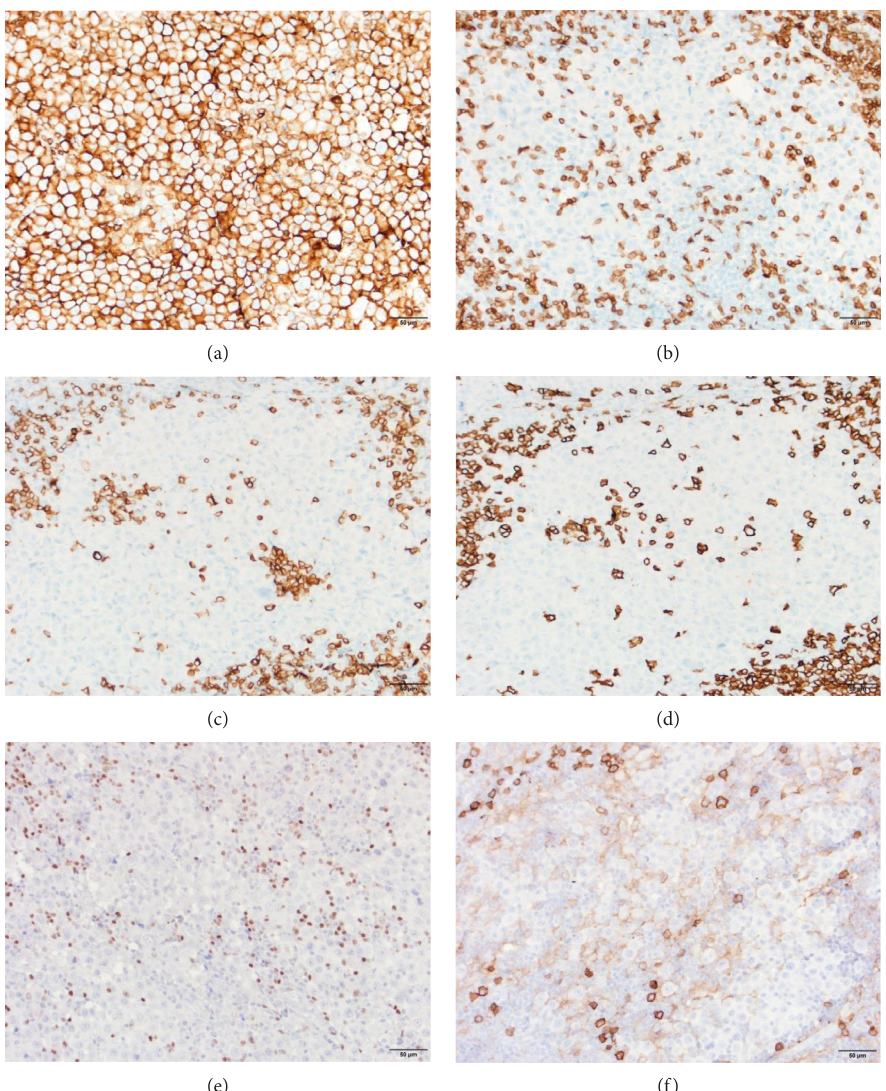
Figure 2: Immunohistochemical stains of the tumor cells. The tumor cells express CD45 (a) and weak CD38 (f) but are negative for CD3 (b), CD20 (c), CD79a (d), and PAX5 (e). All images are at 20x